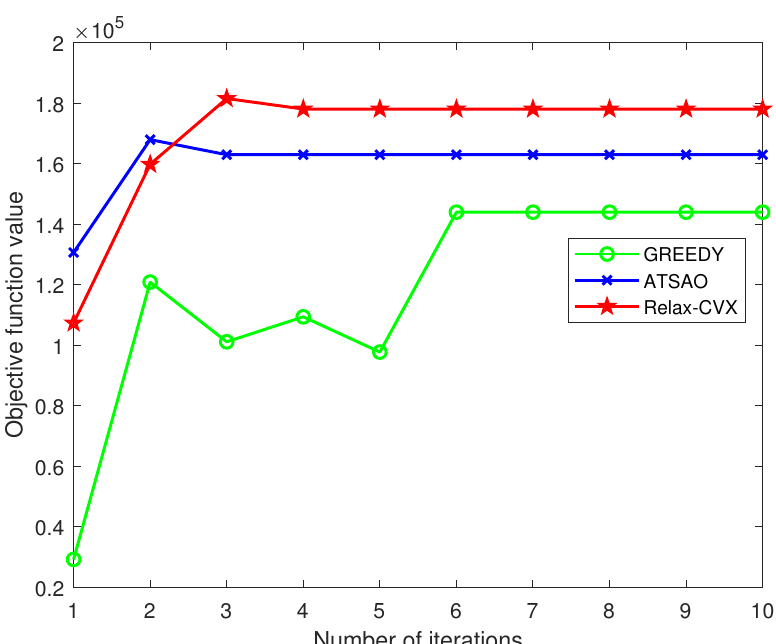
Figure 4. Convergence behaviour of the proposed